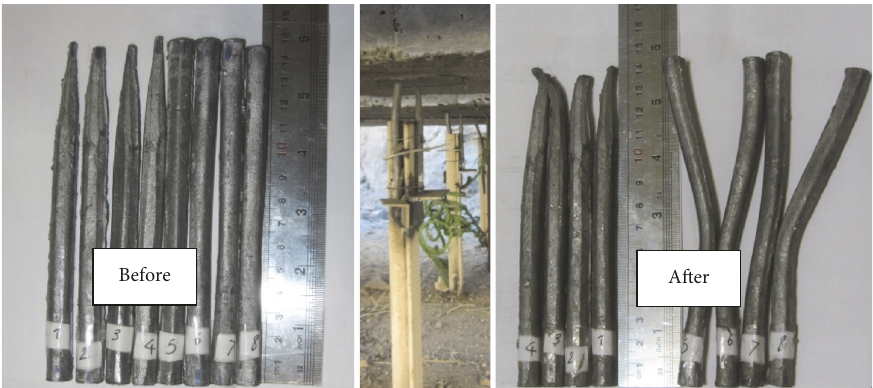
Figure 8: Lead rods installed under the specimen.